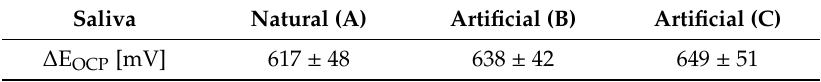
Table 3. Open-circuit potential (OCP) decrease caused by mechanical depassivation due to fretting.